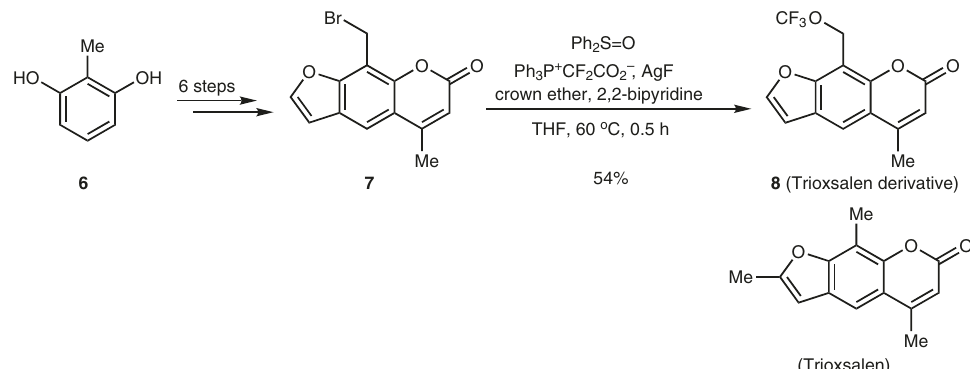
Fig. 5 The synthesis of CF 3 O-containing Trioxsalen derivative. The derivative was synthesized by a late-stage tri fl uoromethoxylation reaction.